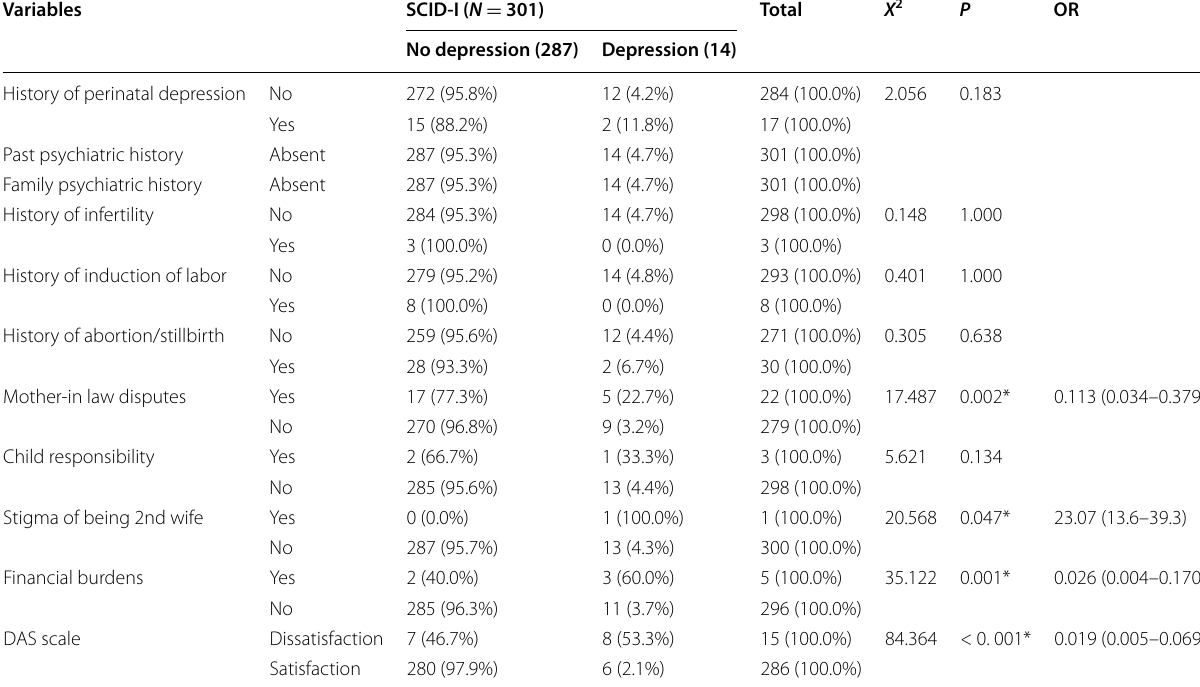
DAS the Dyadic Adjustment Scale, SCID-I the Structured Clinical Interview for DSM-IV; *statistically